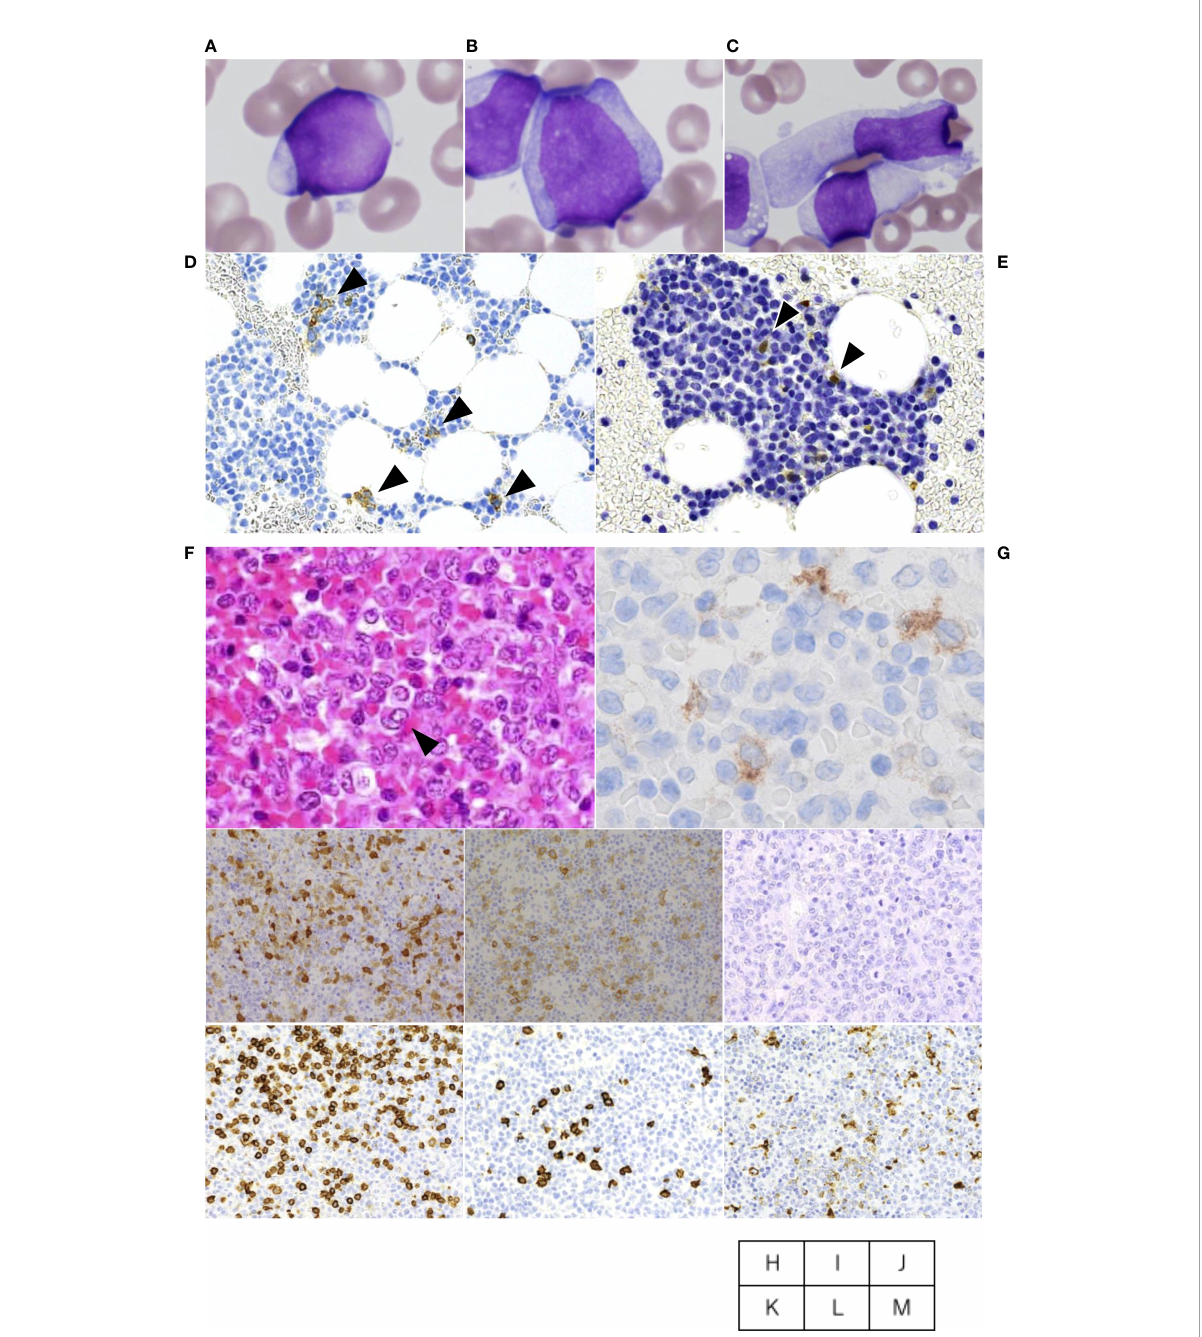
FIGURE 1 Cervical lymph node biopsy and bone marrow aspiration. The aspiration smears of bone marrow show myeloblastic cells accounted for 53.5% (A) and monoblastic cells accounted for 13.8% (B) , whereas dendritic cell-like atypical cells are also found at a frequency of 9.1% (C) . On bone marrow pathology, CD1a (D) - and S-100 (E) -positive atypical cells accounted for 10% of the blasts. Cervical lymph node biopsy specimen shows atypical cells with indented or folded nuclei like one indicated by arrowhead or other ones with mild folding (F) , and immunostaining was Langerin-partially positive (G) , S-100-positive (H) , CD1a-positive (I) , MPO-negative (J) . Around the atypical cells were scattered mononuclear cells positive for CD3 (K) , CD20 (L) , and CD68 (M) in the